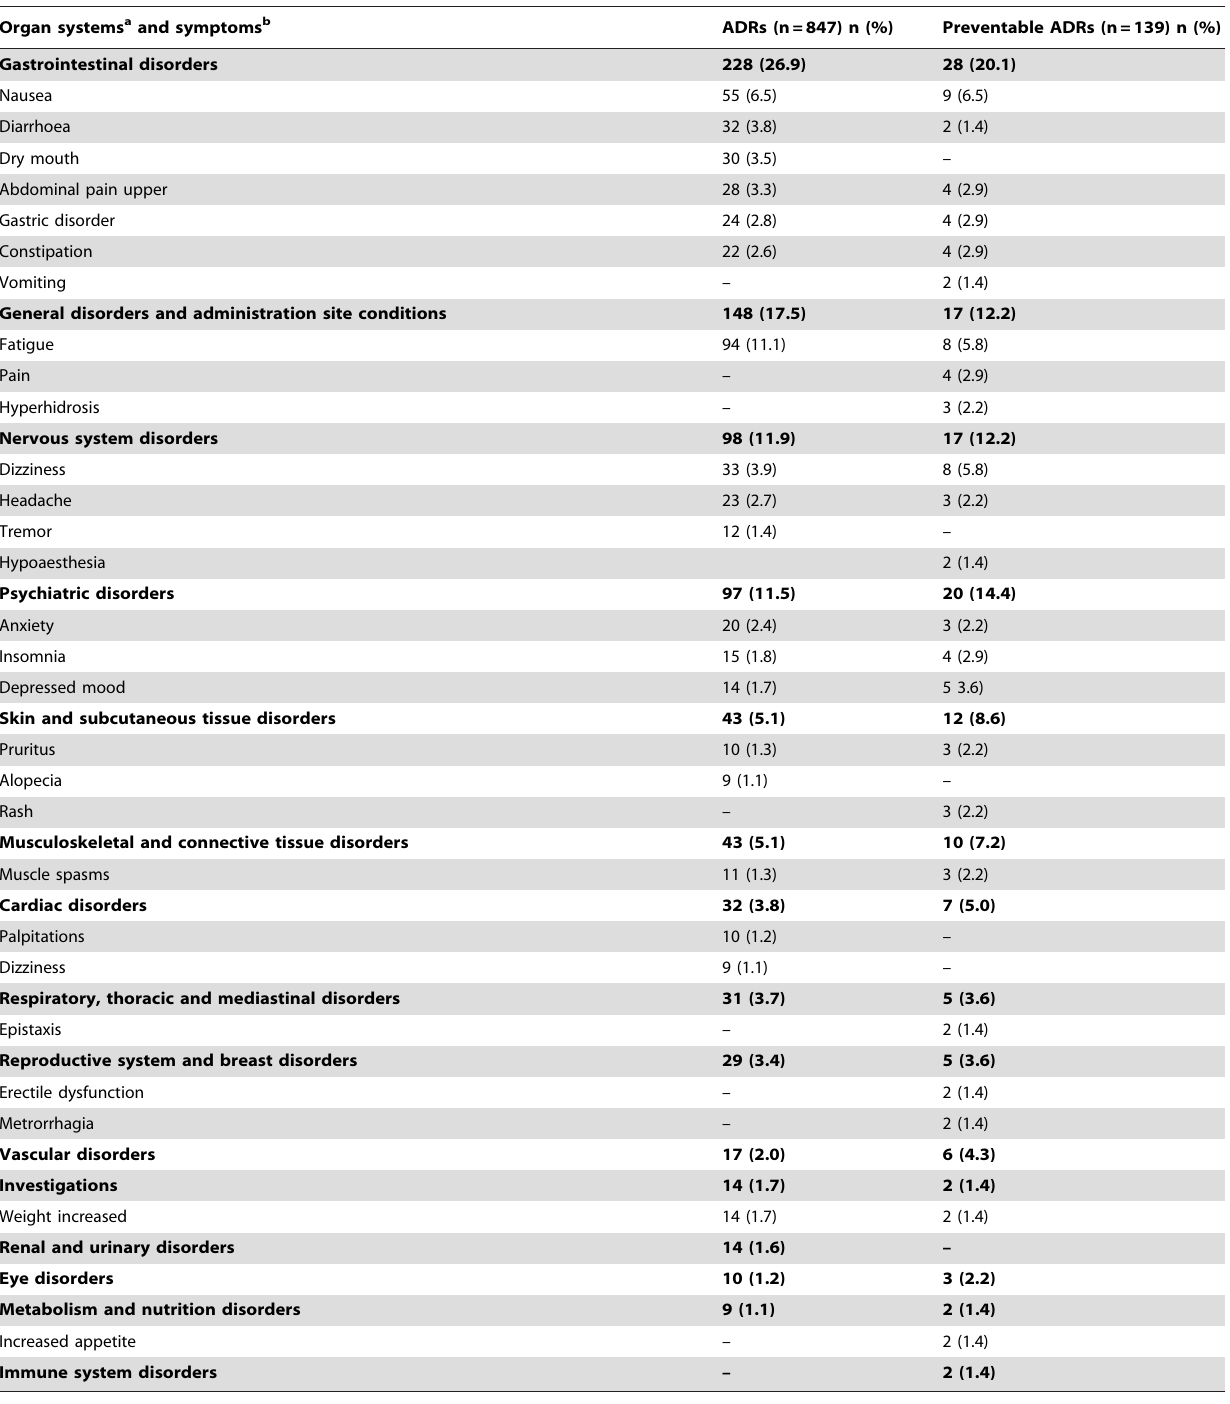
Organ systems a and symptoms b ADRs (n=847) n